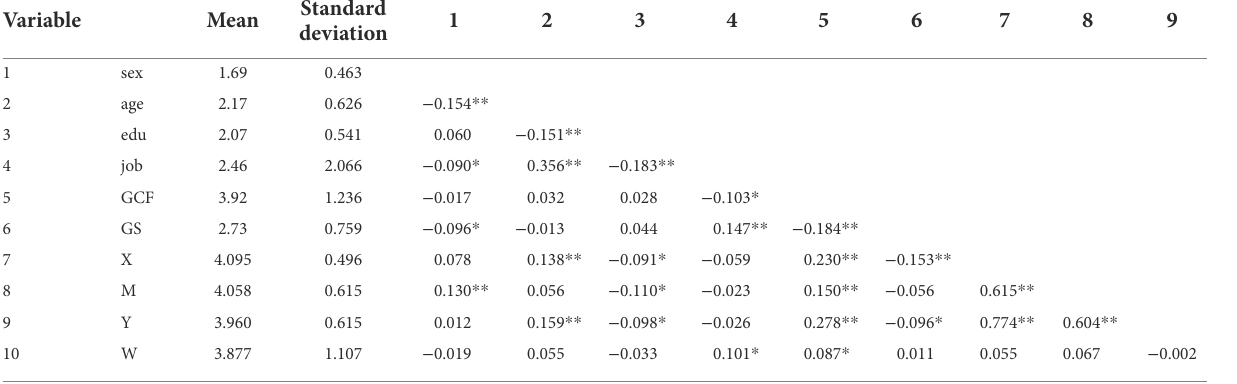
TABLE 3 Descriptive and correlation analysis of main variables ( n = 530).